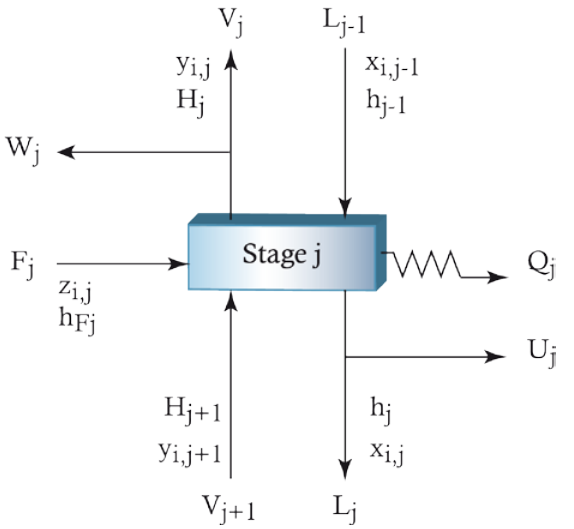
Figure 11. A generic equilibrium stage for the DWC